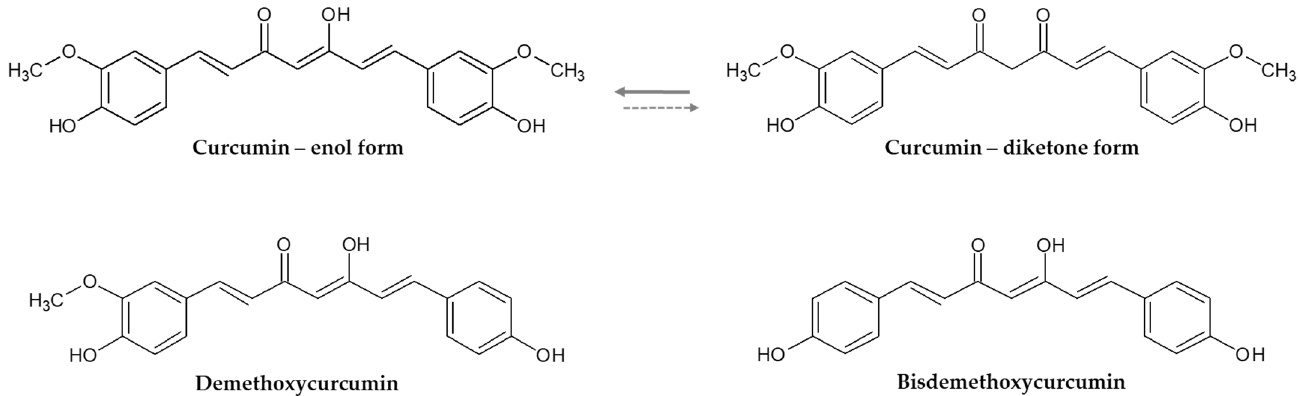
Figure 1. Chemical structure of curcumin and its analogues.